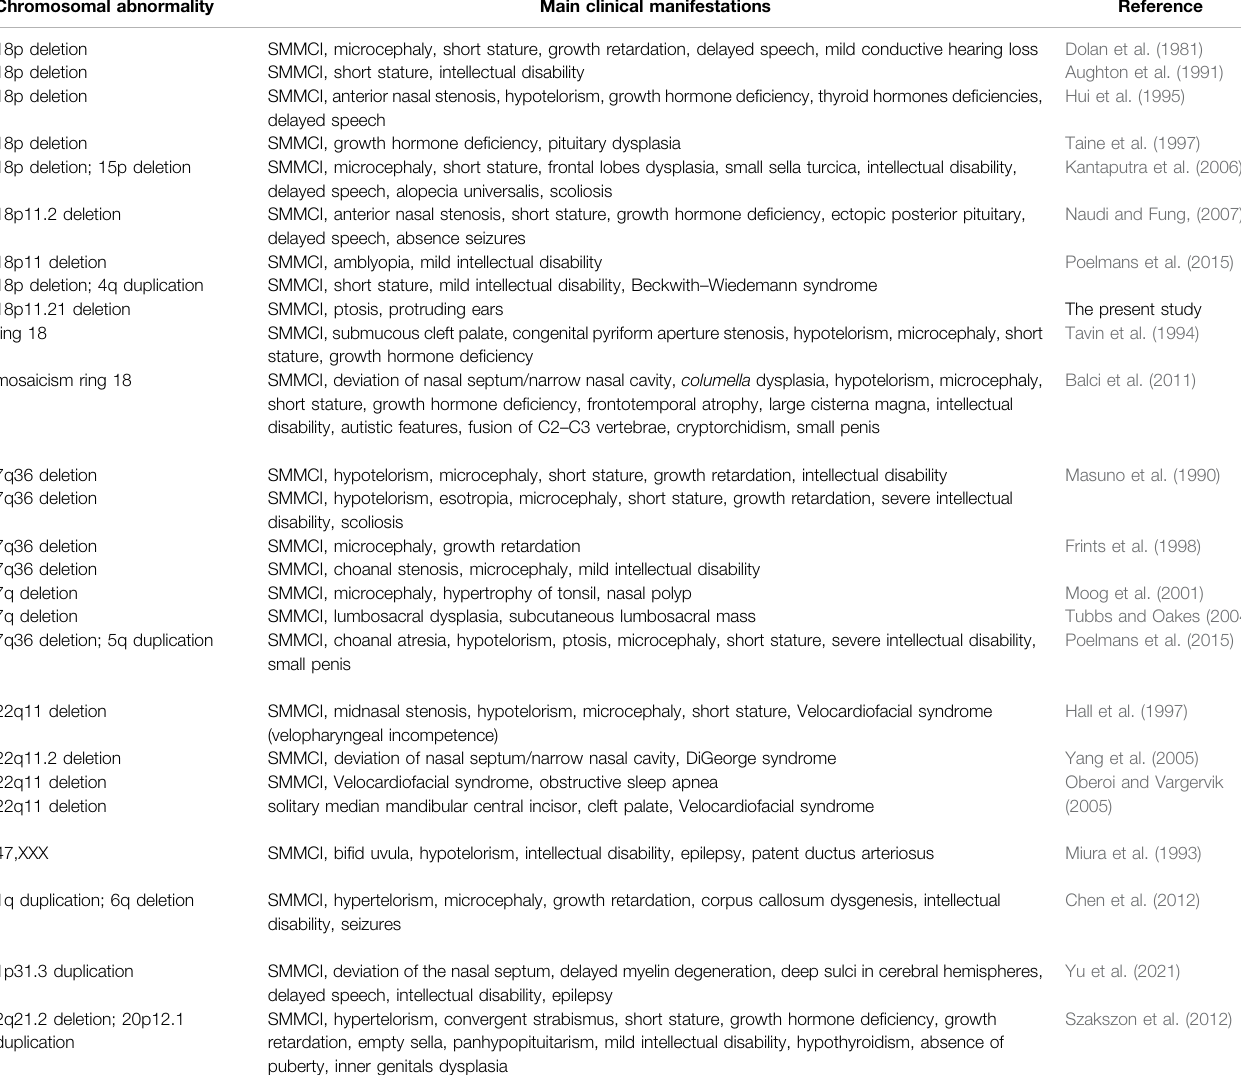
TABLE 2 | Chromosomal abnormalities associated with SMMCI (not HPE) and its main clinical fi ndings. Chromosomal